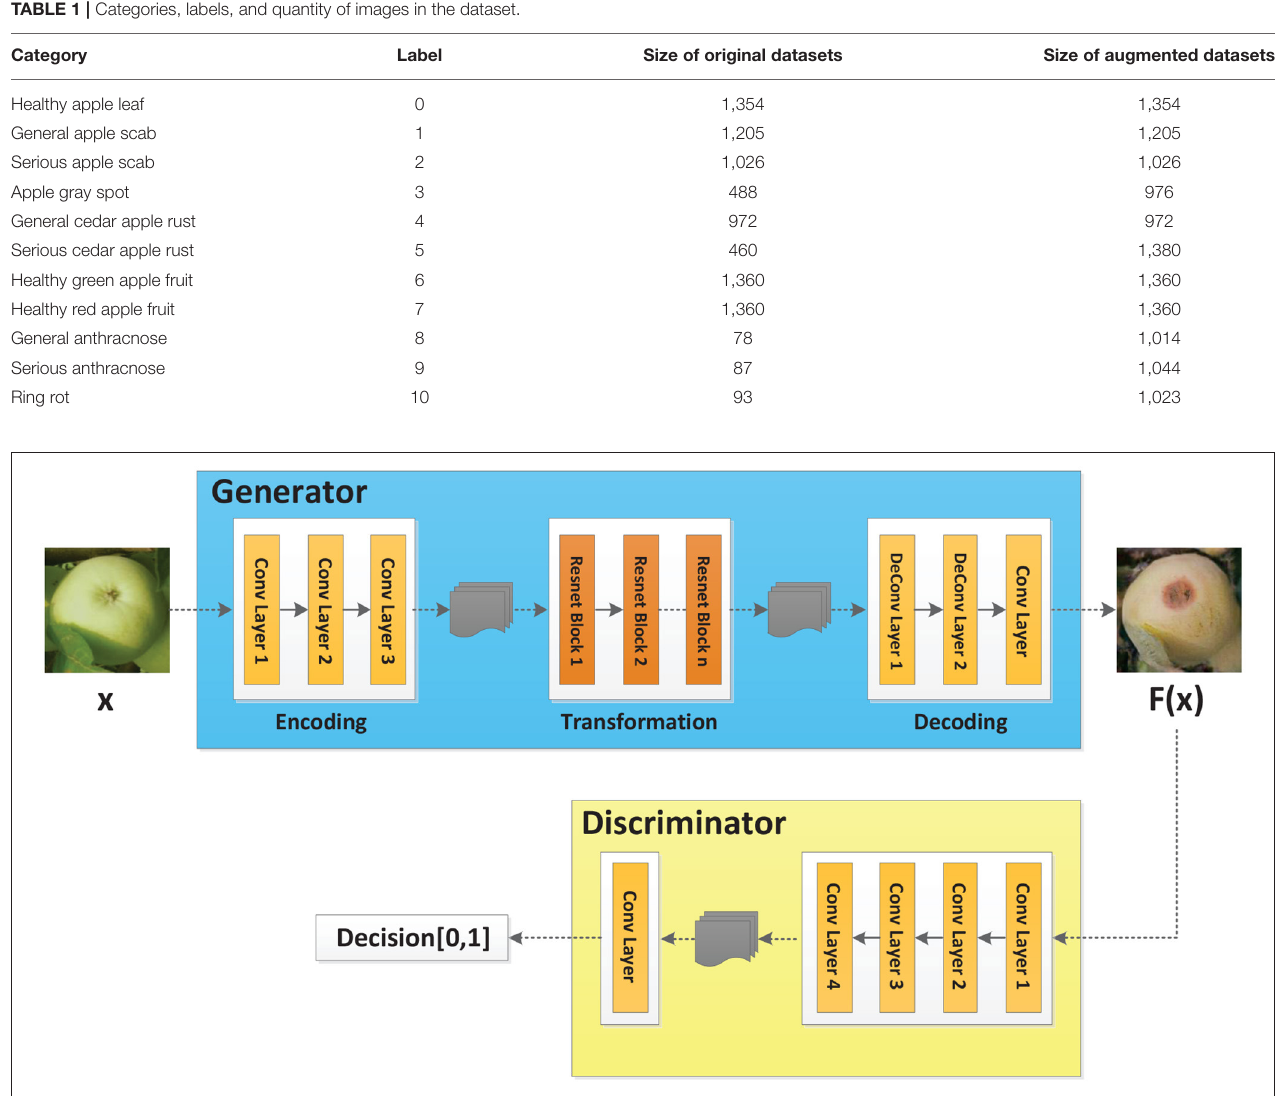
TABLE 1 | Categories, labels, and quantity of images in the dataset. Category Label Size of original datasets